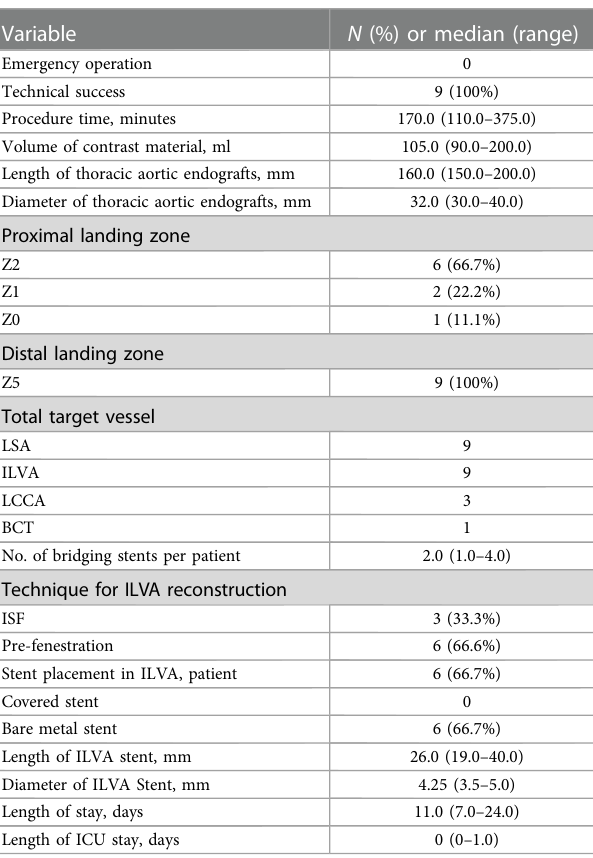
TABLE 1 Demographics and baseline clinical characteristics ( n